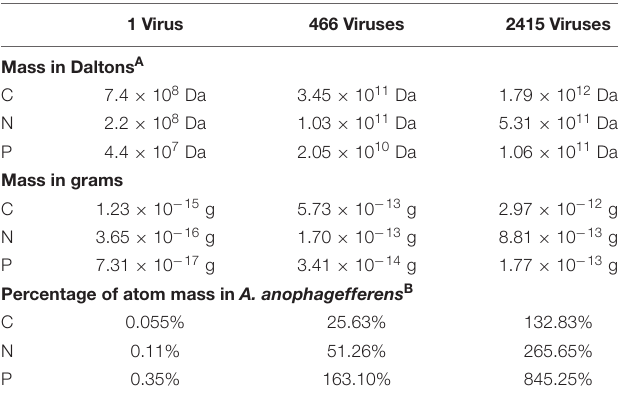
TABLE 2 | Estimated use of atoms within an A. anophagefferens cell to produce new